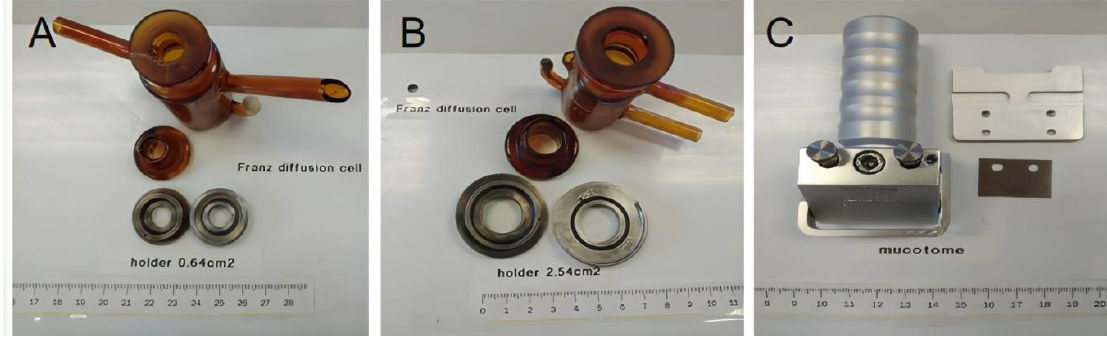
Figure 2. Tools used in permeation tests. ( A ): 0.64 cm 2 Franz di ff usion cell; ( B ): 2.54 cm 2 Franz di ff usion cell and ( C ): mucotome.